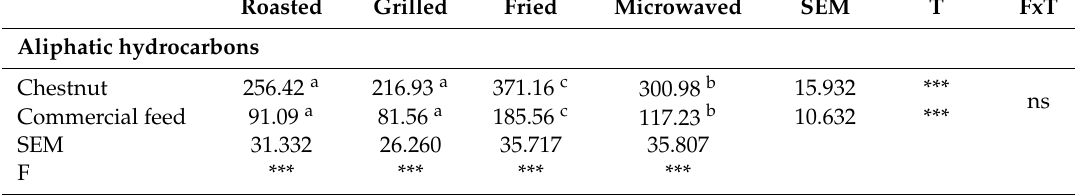
Table 3. E ff ects of the inclusion of chestnut in the finishing diet and of cooking methods on volatile compounds grouped by chemical families and on total volatile compounds (expressed as AU × 10 6 / g dry matter) of Celta pig Biceps femoris